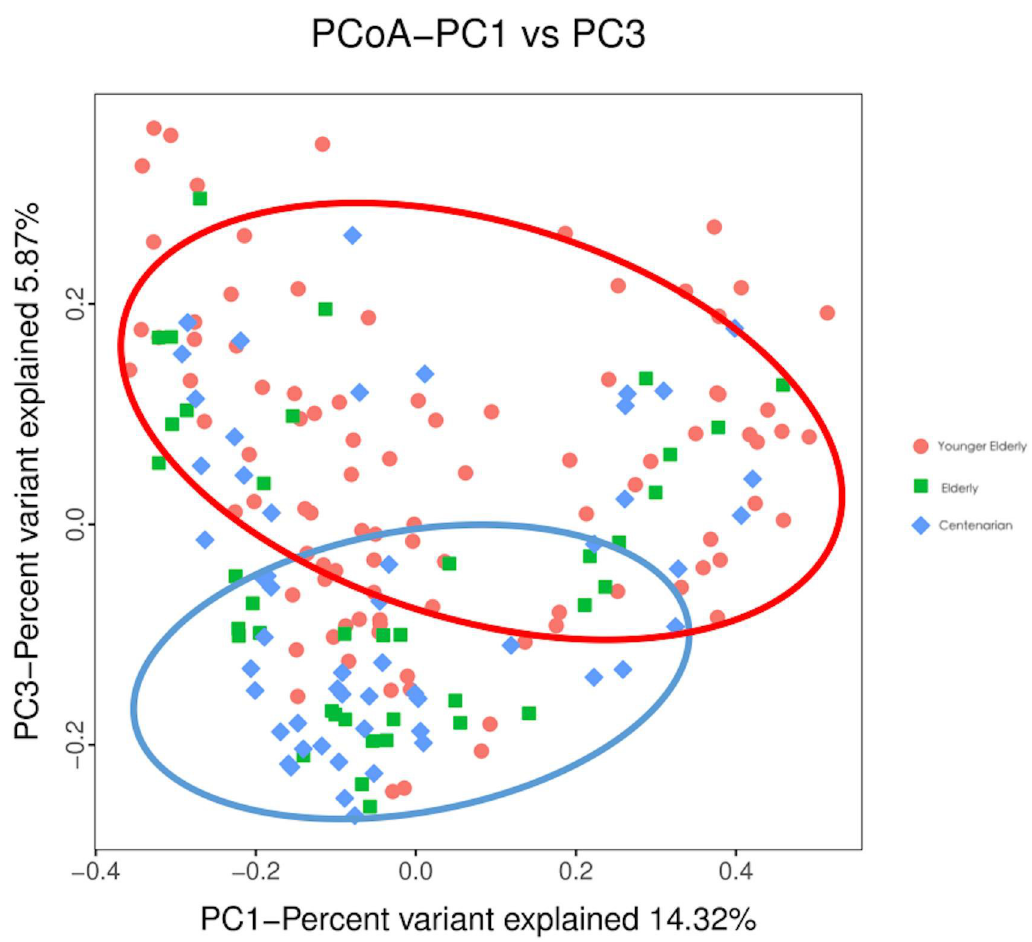
Fig 1. The first and third component of PCoA based on unweighted UniFrac distances � .